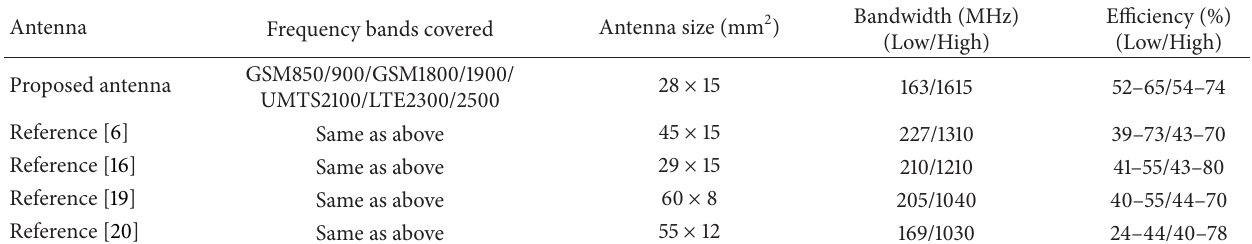
Table 1: Comparison of proposed antenna with reference antennas.